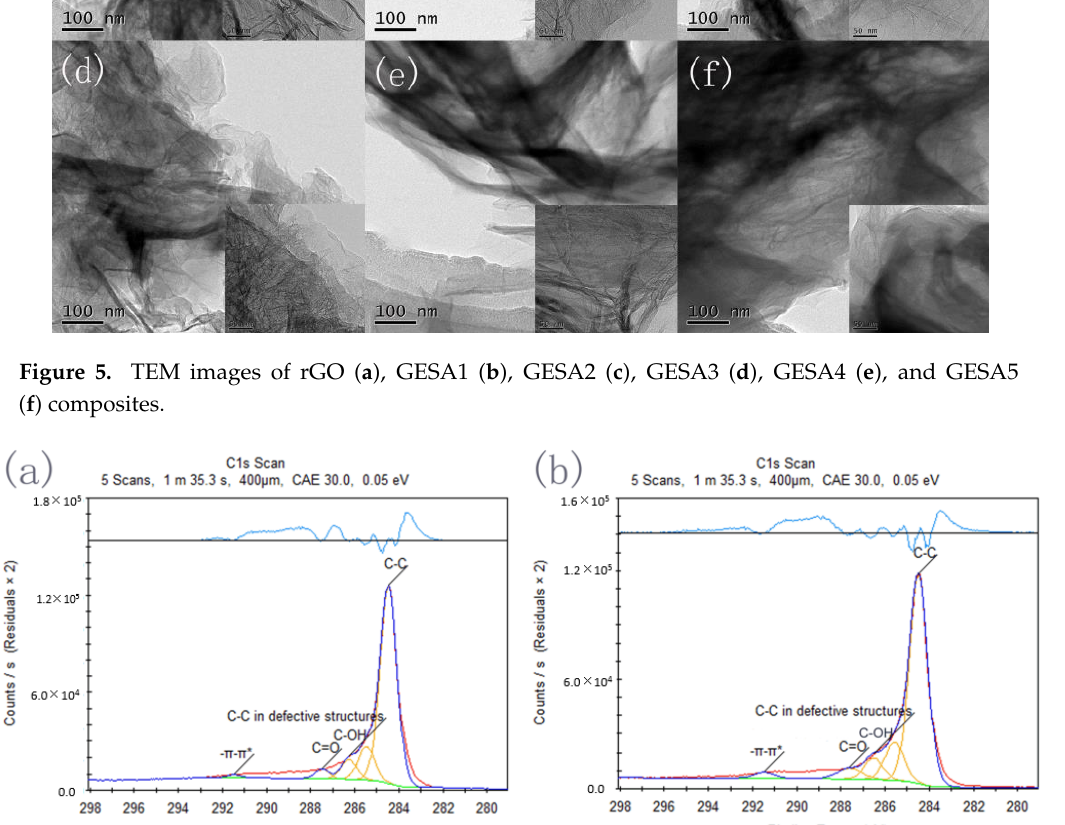
Figure 5. TEM images of rGO ( a ), GESA1 ( b ), GESA2 ( c ), GESA3 ( d ), GESA4 ( e ), and GESA5 ( f ) composites.